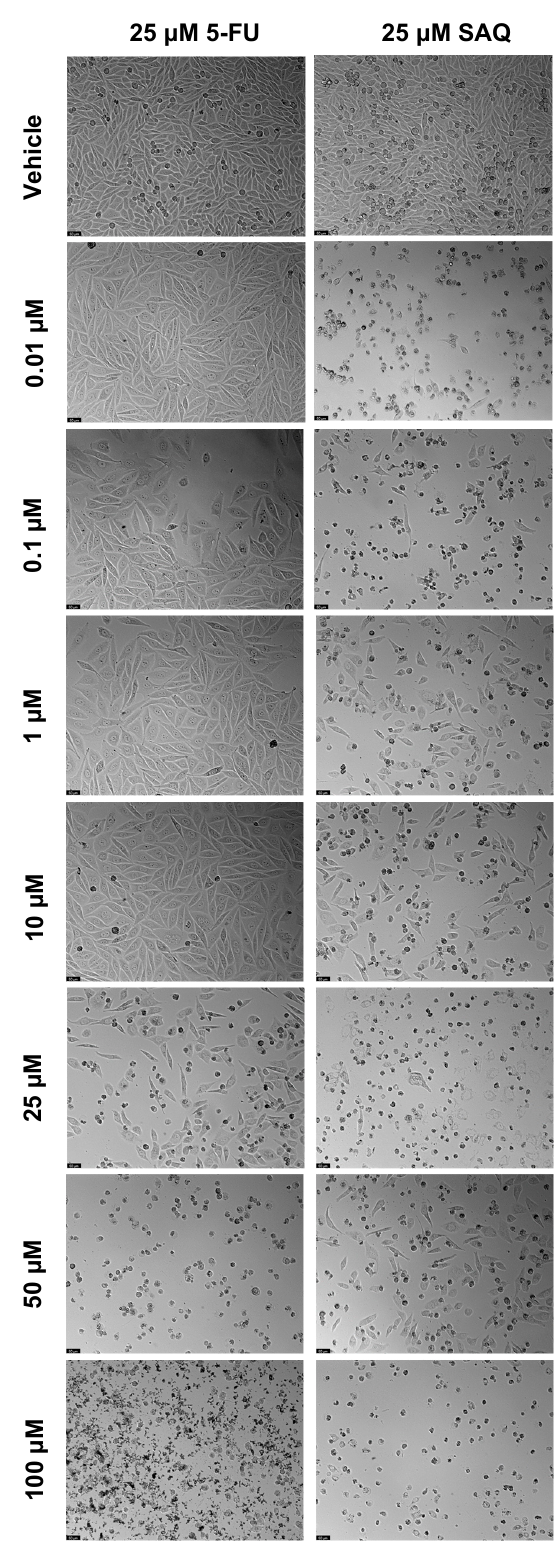
Figure 8. Morphological evaluation of PC-3 after exposure to combinations of 25 μ M of 5-FU with increasing concentrations of saquinavir (0.01–100 μ M) or 25 μ M of saquinavir with increasing concentrations of 5-FU (0.01–100 μ M) for 48 h. Both drugs were added at the same time. Control cells were treated with the vehicle (0.01% DMSO). These images are representative of three independent experiments. The scale bar is 200 μ M.